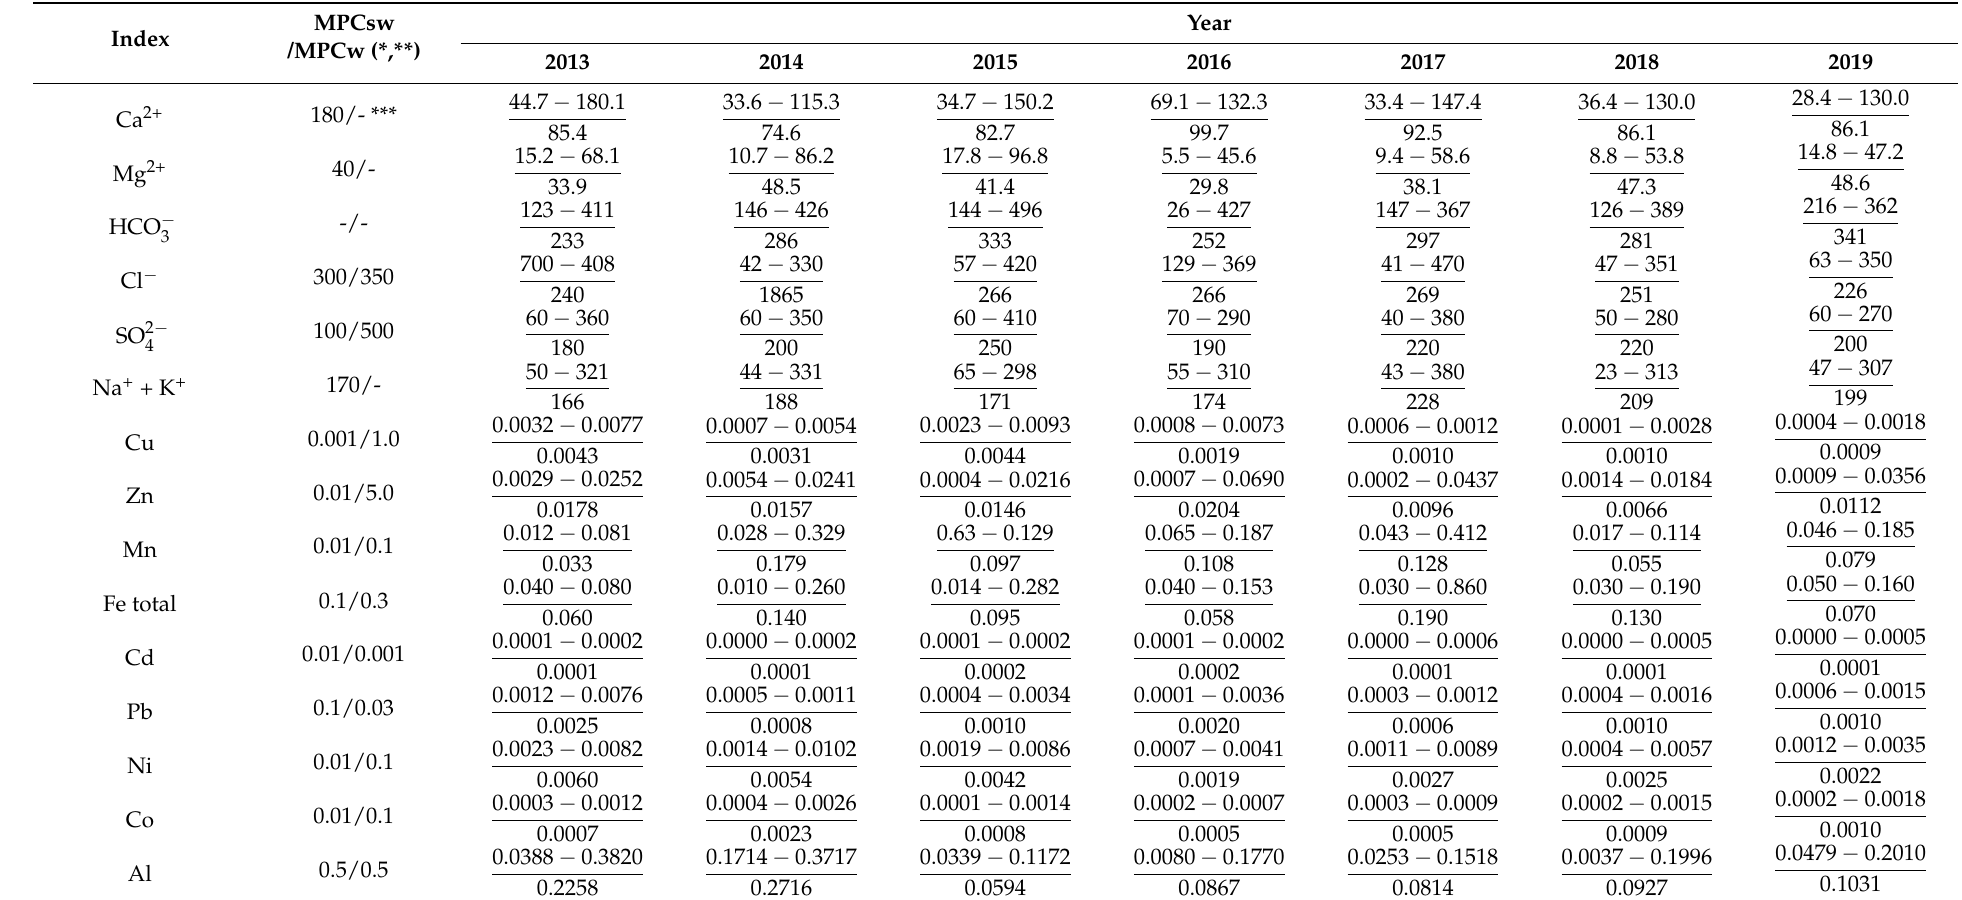
Table 6. Content of main ions, microelements and heavy metals in the Ishim River 2013–2019